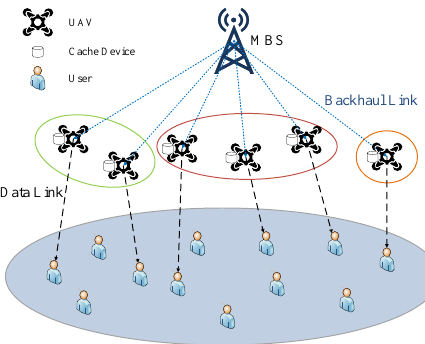
Figure 1. Cache-enabled, UAV-assisted network.